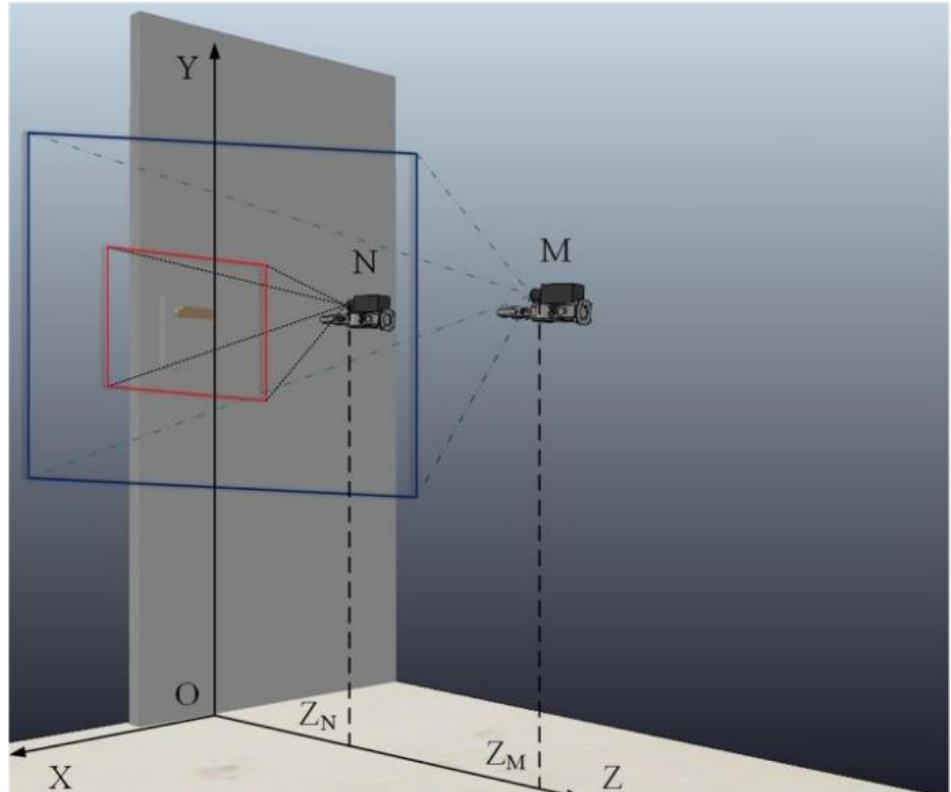
Figure 2. The position transformation of the camera.